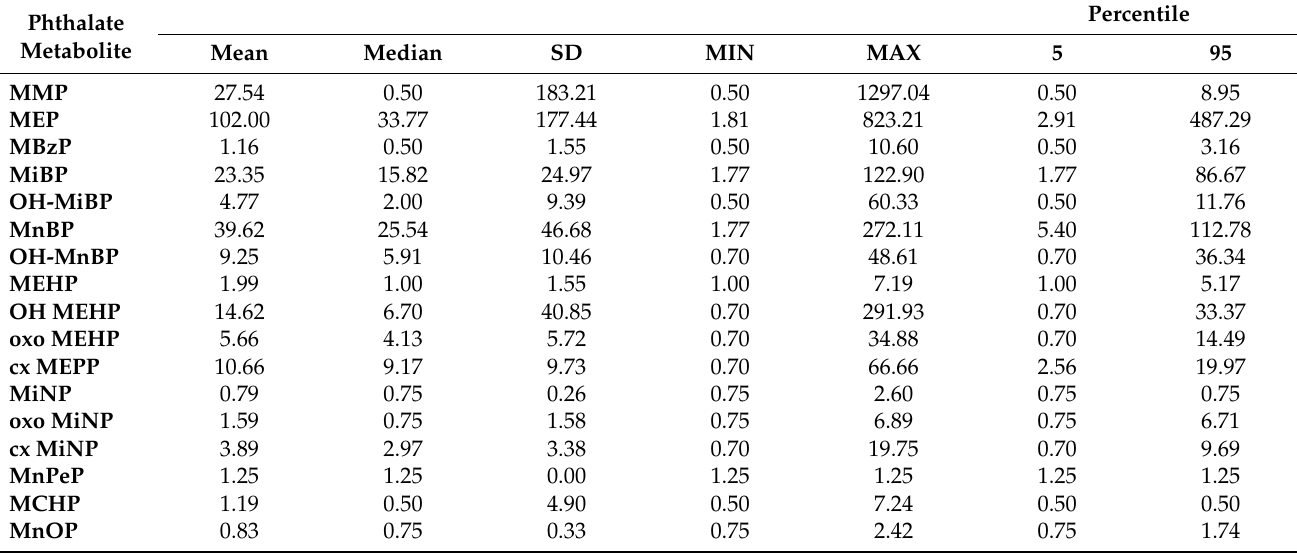
Table 2. Descriptive statistics of urinary phthalate metabolites